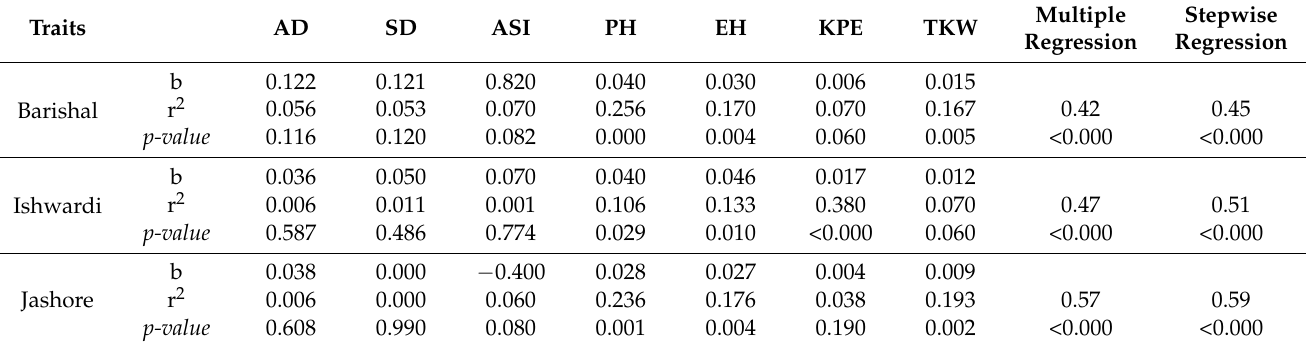
Table 5. Initial model and final models for different locations were obtained from stepwise regression.